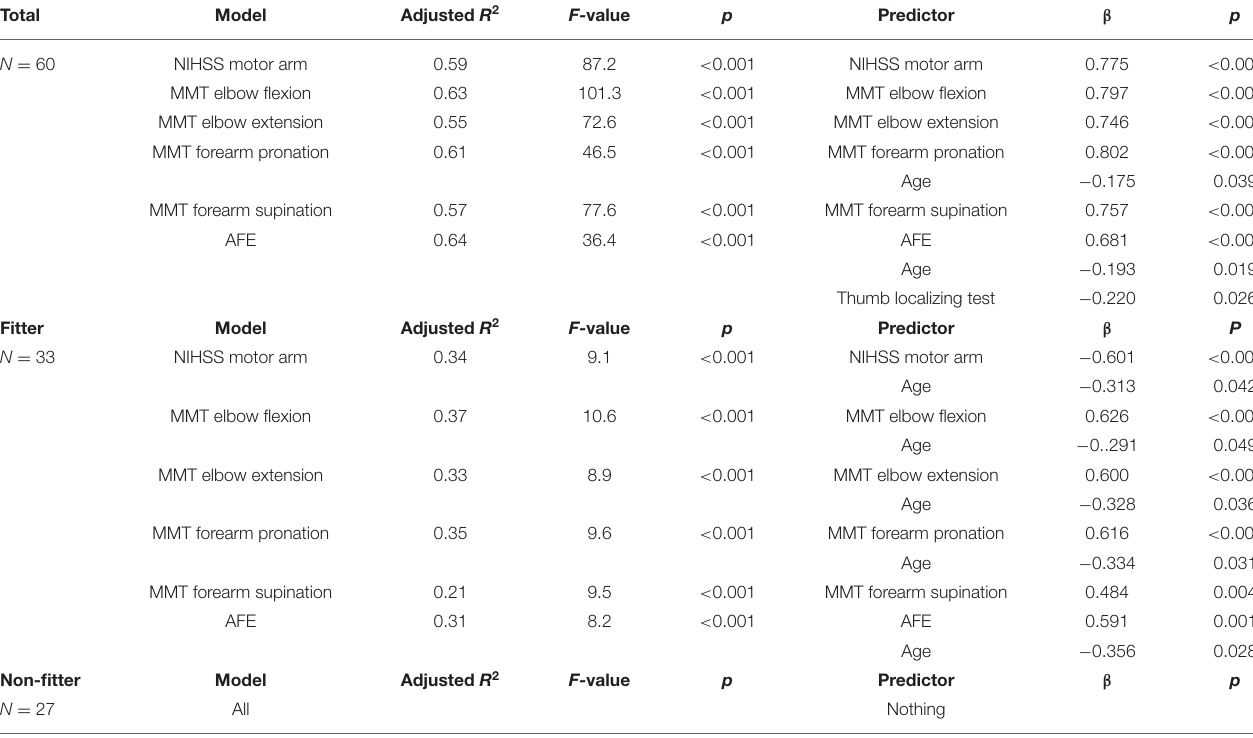
TABLE 5 | Linear regression statistics for predictors of ARAT at 3